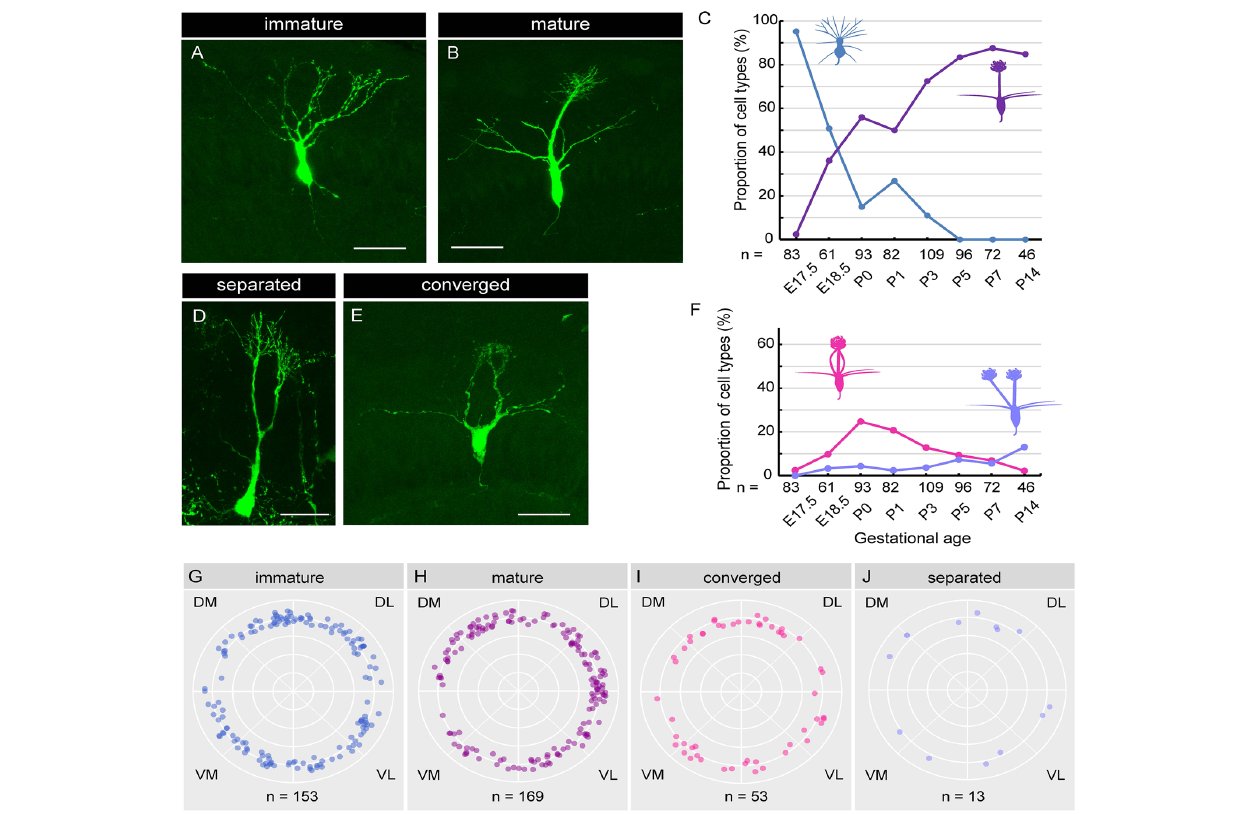
FIGURE 5 | Single-cell analysis of dendrite development in mitral cells. (A,B) Representative images of “immature type” (A) and “mature type” (B) mitral cells, respectively. (C) The perinatal changes in the proportions of “immature type” and “mature type” mitral cells. (D,E) Representative images of “separated type” (D) and “converged type” (E) mitral cells, respectively. (F) The perinatal changes in the proportions of “separated type” and “converged type” mitral cells. (G–J) Azimuth distribution of AAV-labeled mitral cells with immature (G) , mature (H) , converged (I) , and separated (J) dendrites. Rao’s spacing test of uniformity showed no significant deflection in the coronal sections. DM, dorsomedial; DL, dorsolateral; VM, ventromedial; VL, ventrolateral. The numbers of mice counted are 10, 6, 13 (five males and eight females), 14 (seven males and seven females), 10 (four males and six females), 7 (three males and four females), 7 (four males and three females), and 5 (two males and three females) for E17. 5, E18.5, P0, P1, P3, P5, P7 and P14, respectively. The sex of pups analyzed at E17.5 and E18.5 was not determined. Scale bars, 50 µ